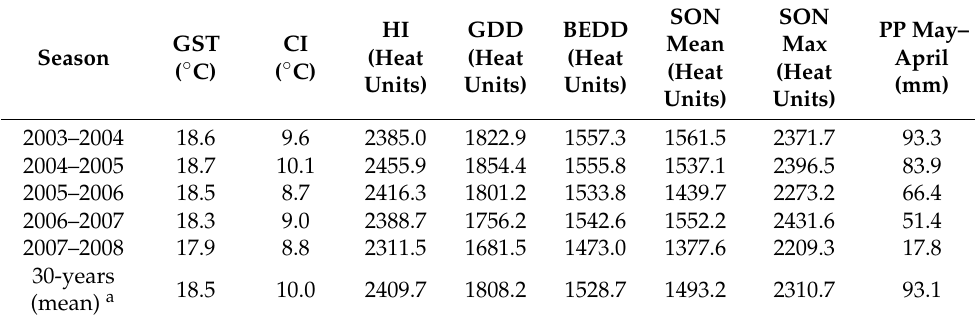
Table 1. Bioclimatic indices calculated each season of study.